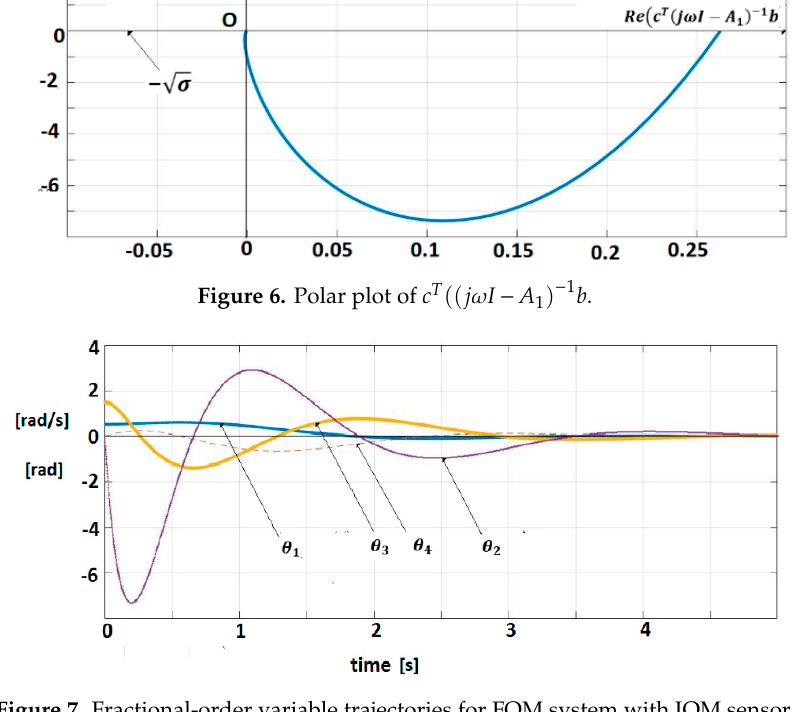
Figure 7. Fractional-order variable trajectories for FOM system with IOM sensor.